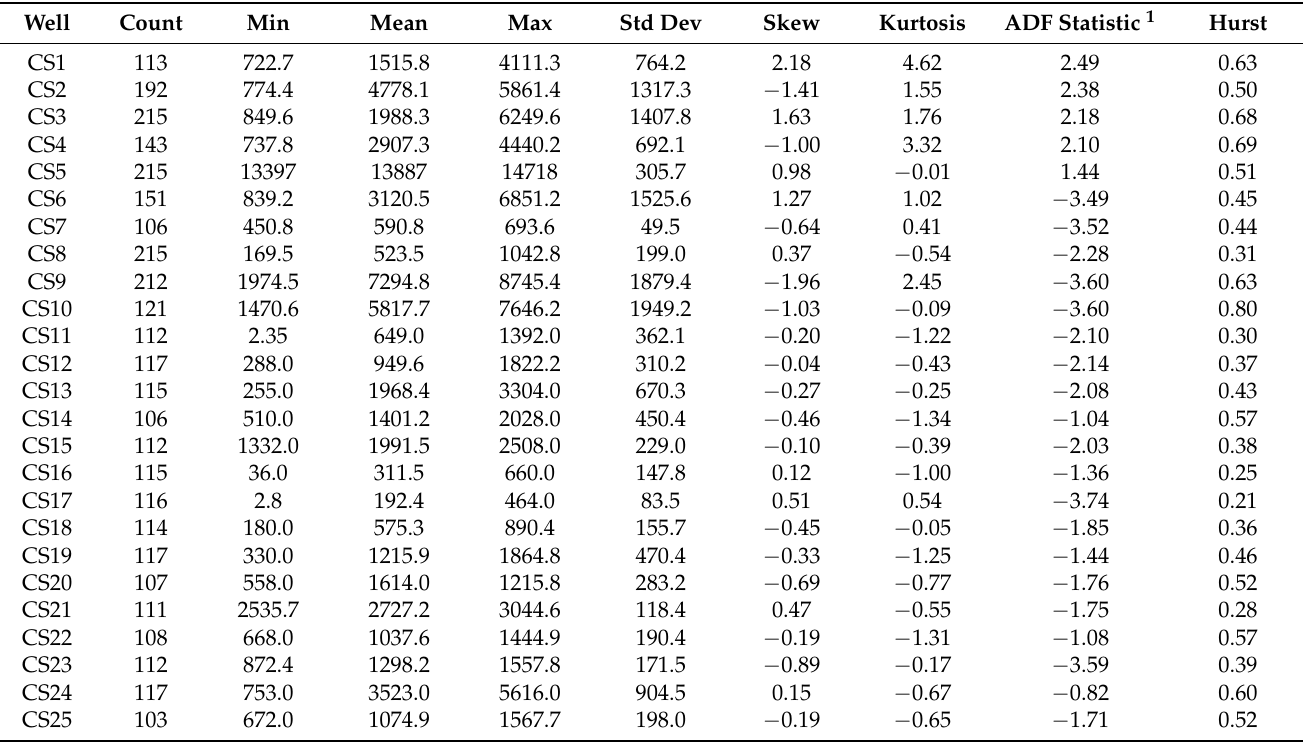
Table 2. Descriptive statistic of Central Sumatra Basin